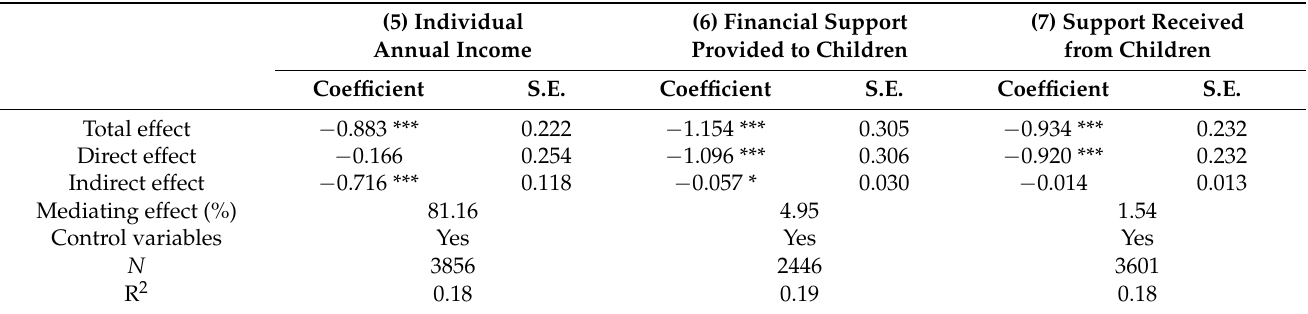
Table 7. Mediating Effects using the KHB-Method.